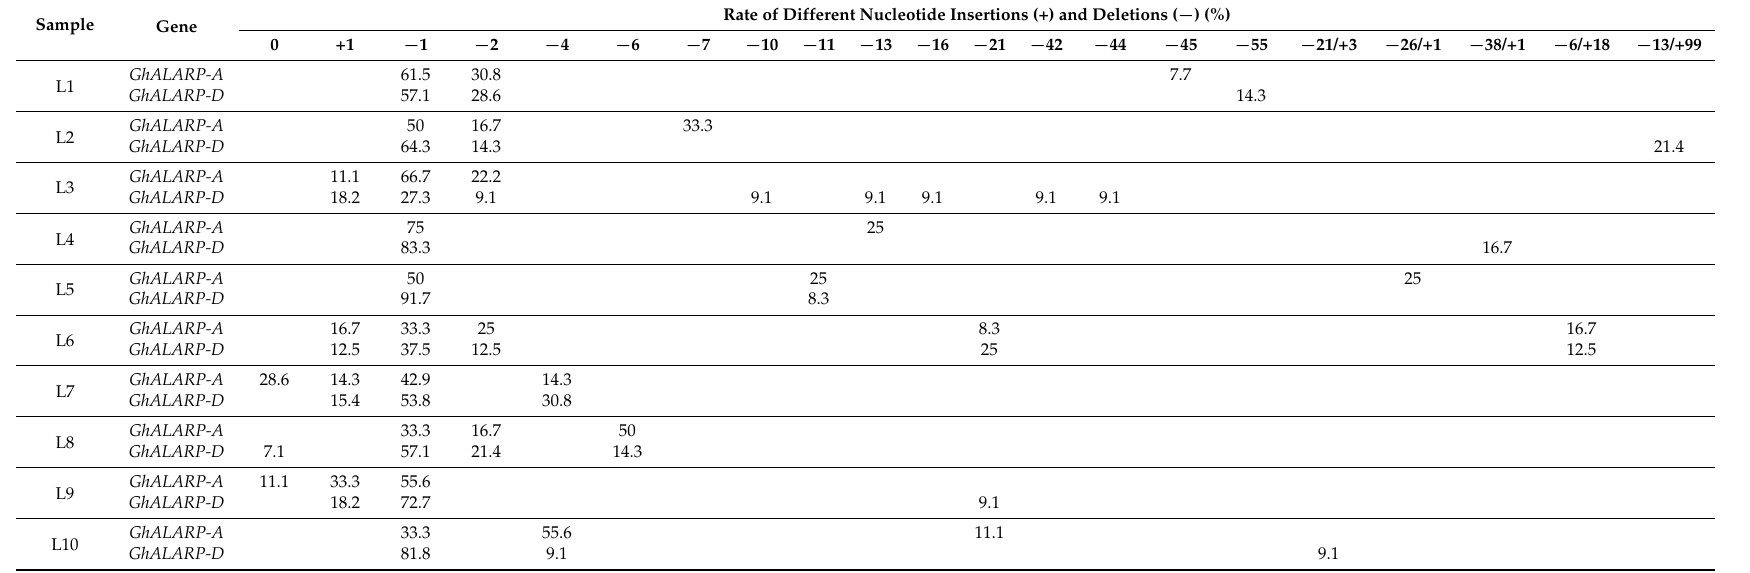
Table 1. Percentage of different mutation events in GhALARP induced by